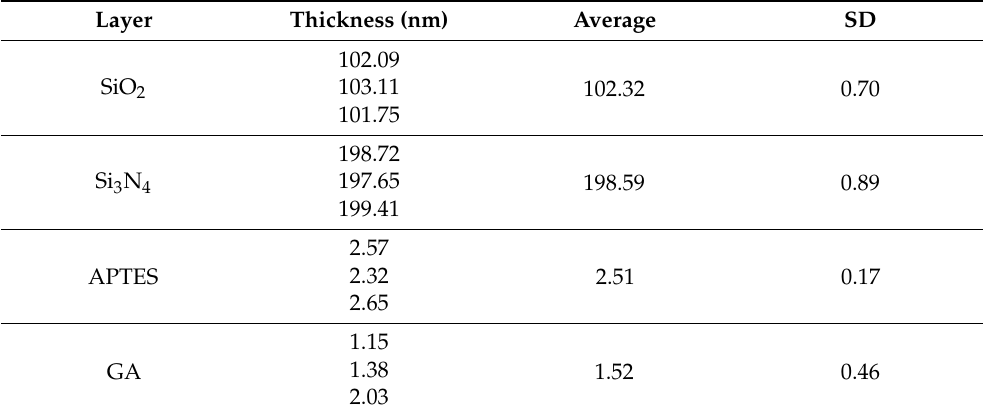
Table 1. The measurement of the thicknesses of different layers of Si 3 N 4 modification using APTES and APTES-GA